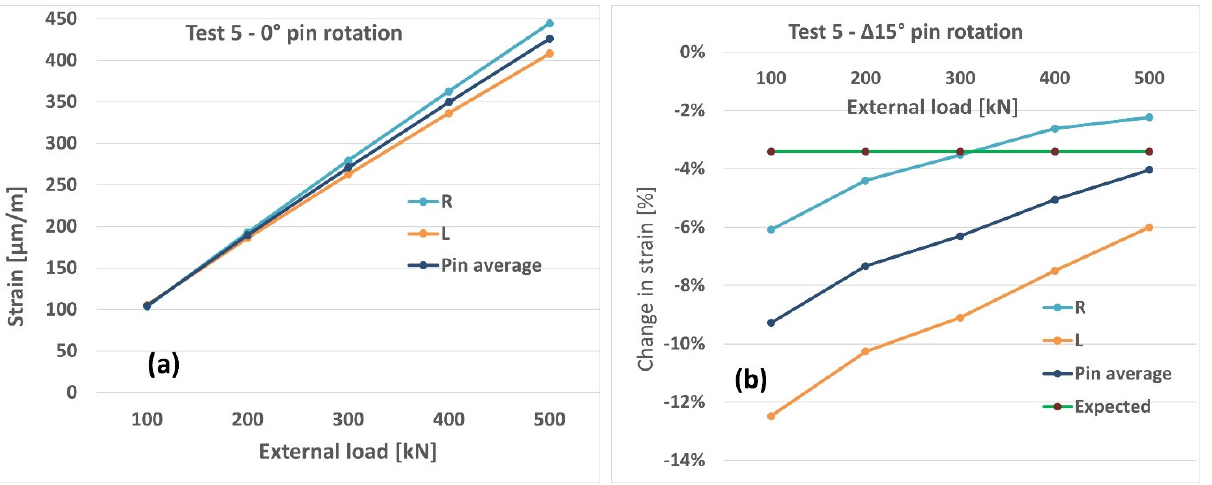
Figure 13. Test 5, ( a ) strains at 0° position, ( b ) percentage change of strains from 0° to 15° position.